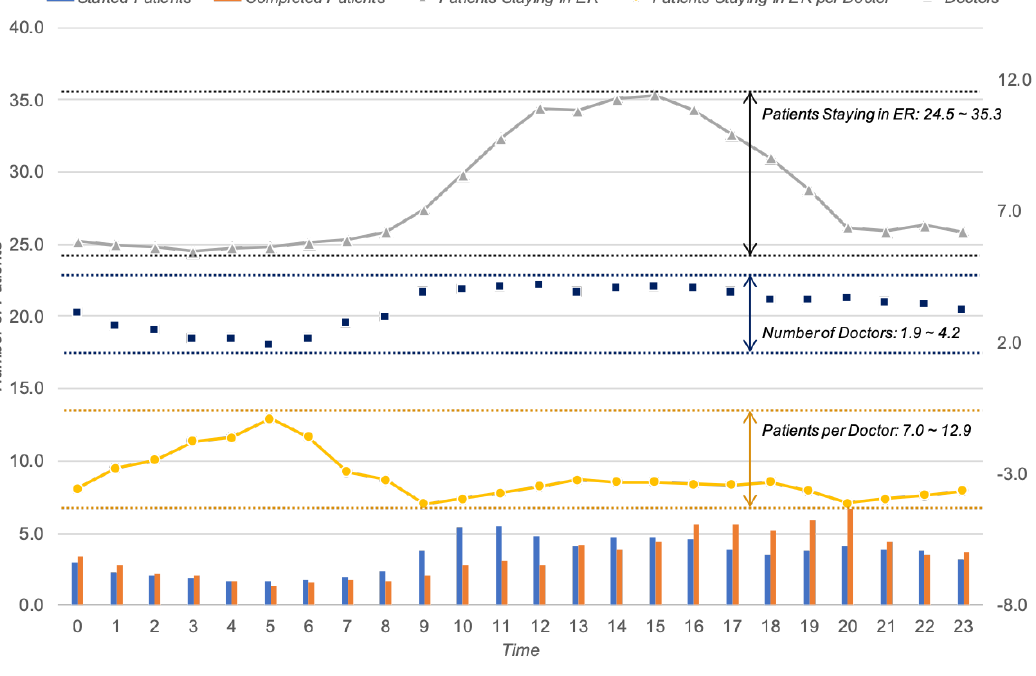
Figure 4. The resource-related analysis result for the cost and quality